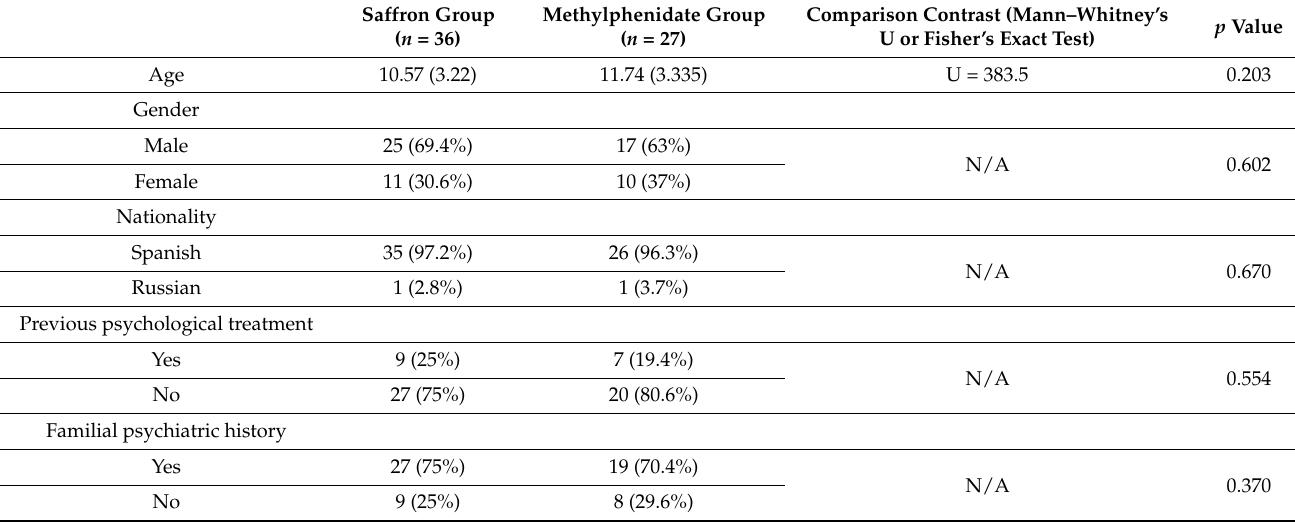
Table 1. Sociodemographic factors *.